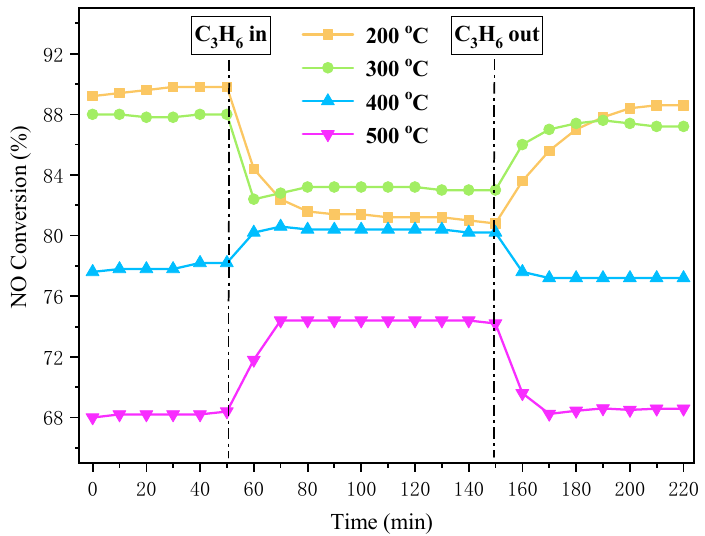
Figure 4. The gas-switch experiments of Cu-SAPO-34 with propylene at different temperatures, reaction condition: 0.1 g catalyst, 500 ppm NO, 500 ppm NH 3 , 10% O 2 and N 2 as balance gas. GHSV = 300,000 h − 1 .